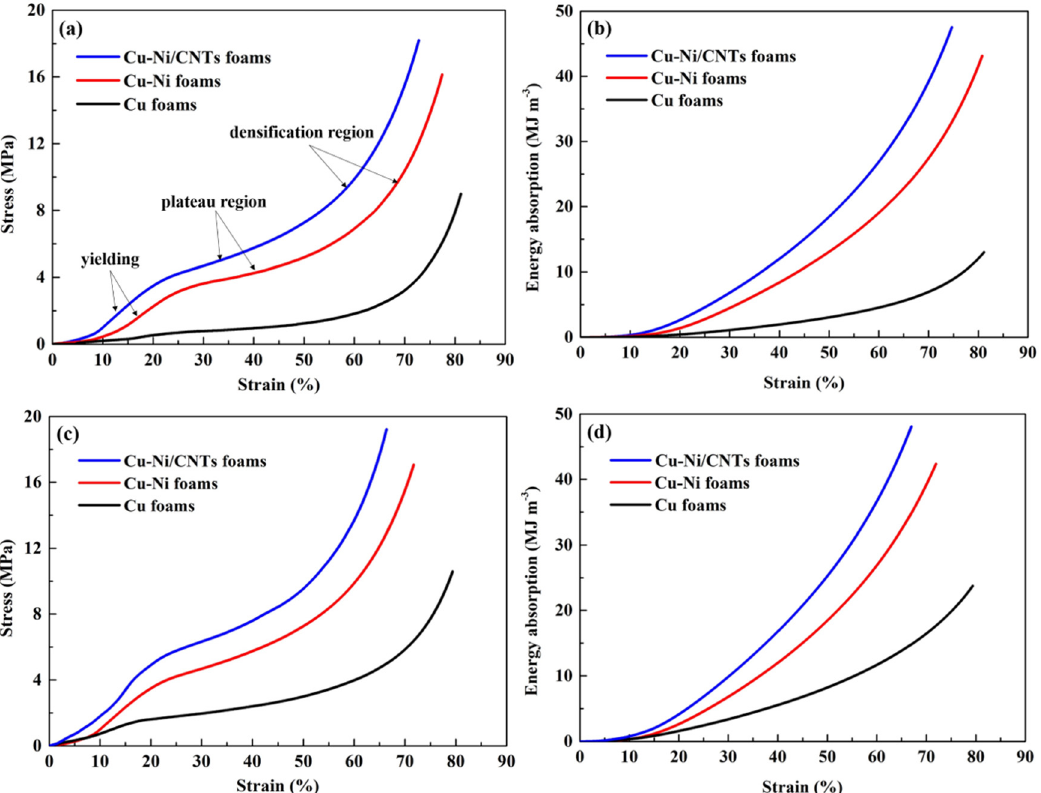
Figure 7. The compressive properties of Cu foams, Cu-Ni foams and Cu-Ni/CNTs foams; ( a ) stress − strain curves before heat treatment; ( b ) energy absorption capacity before heat treatment; ( c ) stress − strain curves after heat treatment; ( d ) energy absorption capacity after heat treatment.